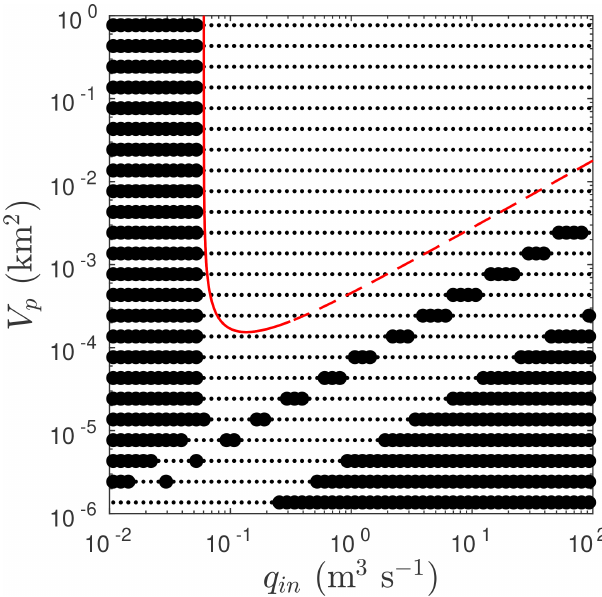
Figure 12. Stability boundary plotted in the same way as in Fig. 2, but with (cid:57) 0 = 1630Pam − 1 and u b h r = 1 . 05 × 10 − 7 m 2 s − 1 , and we put L =